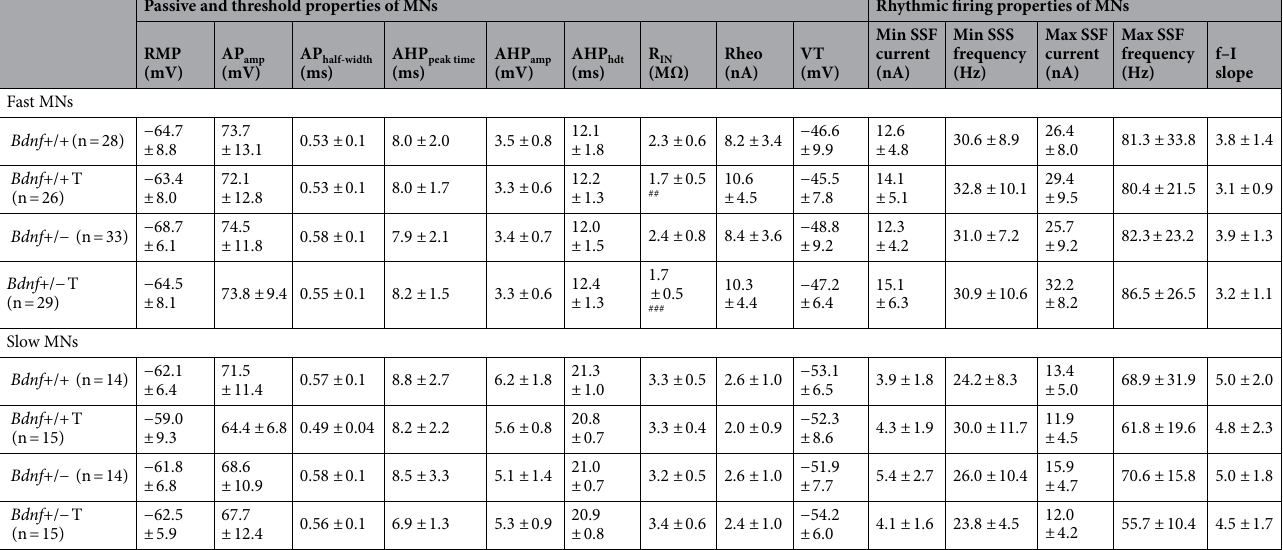
Table 1. The mean values (± SD) of passive, threshold, and rhythmic firing properties of fast and slow MNs from Bdnf +/+, Bdnf +/+ T, Bdnf +/−, and Bdnf +/− T rats. Differences between Bdnf +/− and Bdnf +/− T rats are statistically significant at ## p < 0.01; ### p < 0.001 (two-way ANOVA with genotype and training as fixed factors and Tukey’s HSD post-hoc test). n number of MNs, RMP resting membrane potential, AP amp action potential amplitude,